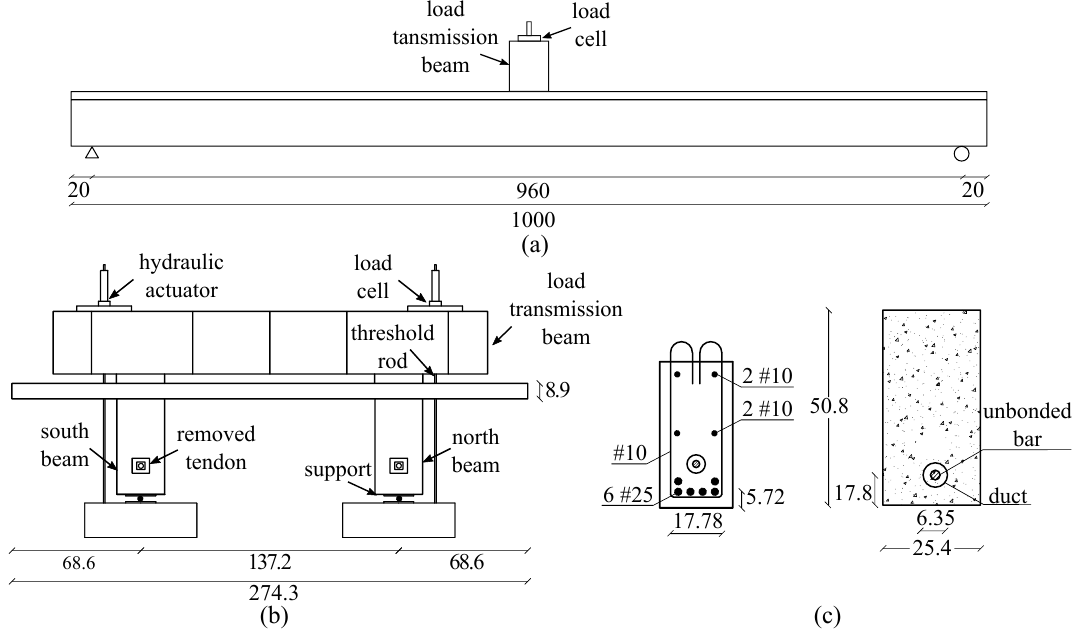
Figure 5. Detailing of the tested specimen: ( a ) elevation view; ( b ) typical cross-section; and ( c ) reinforcement distribution and cross-section design of a beam (dimensions are in